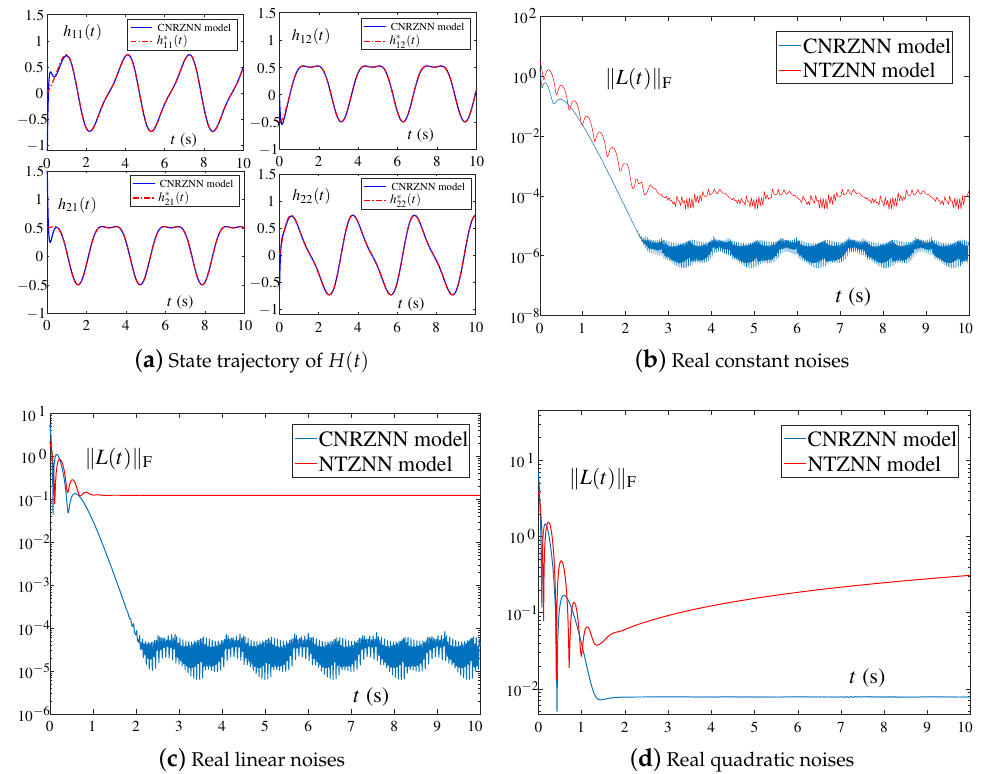
Figure 8. CNRZNN model with ζ = 8 solves Lyapunov Equation (16) starting from initial complex matrices [ 2,2 ] 2 × 2 under real constant noises [ 8 ] 2 × 2 , real linear noises [ 8 t ] 2 × 2 and real quadratic − noises [ t 2 ] 2 × 2